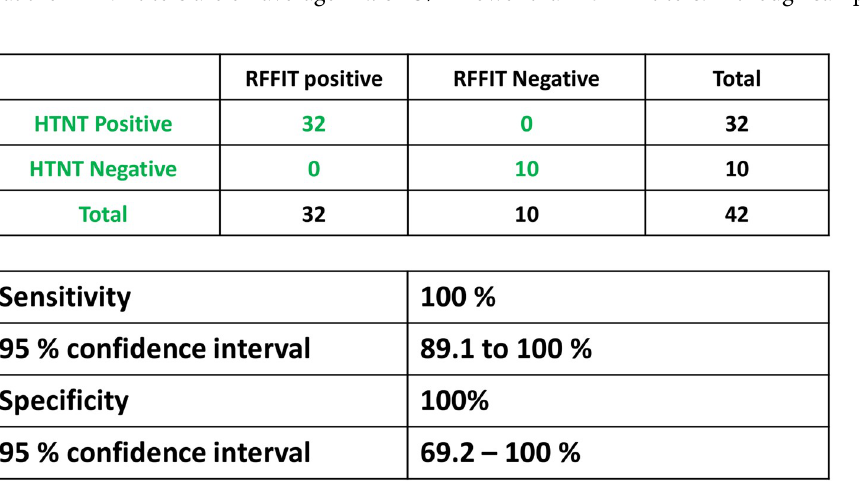
Fig 4. Sensitivity and specificity of animal sera. Neutralization capability of rabies-specific antibodies in animal determined similar to Fig 4. Sensitivity and specificity of HTNT assay for detection of rabies VNAs were calculated based on the RFFIT results and tabulated with 95% confidence interval